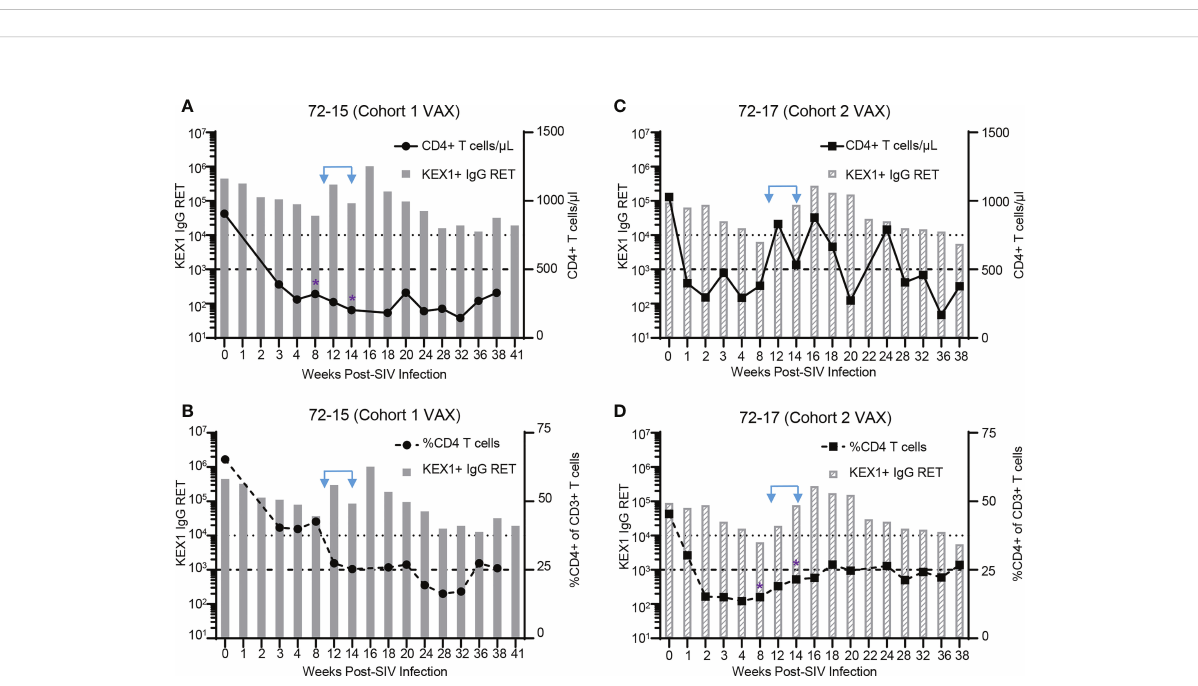
FIGURE 5 KEX1-antibody responsesintherapeutically boostedanimalswithsevereCD4+Tcell depletion. CD4+Tcell depletionpro fi lesandKEX1antibody responsesduringSIVin a -GC+KEX1boostedmacaques (A,B) 72-15(Cohort1VAX)and (C,D) 72-17(Cohort2 VAX). (A,C) Peripheral bloodCD4+Tcell numbersandplasmaKEX1IgGreciprocal endpoint titer(RET)throughoutSIVinfection.Thickdashedline indicates500CD4+Tcells/ m L. (B, D) Frequencies ofperipheral bloodCD4+TcellsandplasmaKEX1IgGRET throughout SIVinfection. Thickdashedlineindicates25%CD4+ofCD3T cells. Dotteddashed lineindicatesthecorrelateofprotectionat 10,000KEX1IgGRET.Bluearrowsindicate therapeuticboostingwith a -GC+KEX1at10and 14weekspost- infections. Purpleasterisksindicate timepointsimmediately precedingorat thetimeof therapeuticboosting, where (A) CD4+Tcellswerelessthan500 CD4+Tcells/ m Linanimal72-15(Cohort1VAX)or (D) thefrequencyof CD4 Tcellswaslessthan25%inanimal 72-17(Cohort2